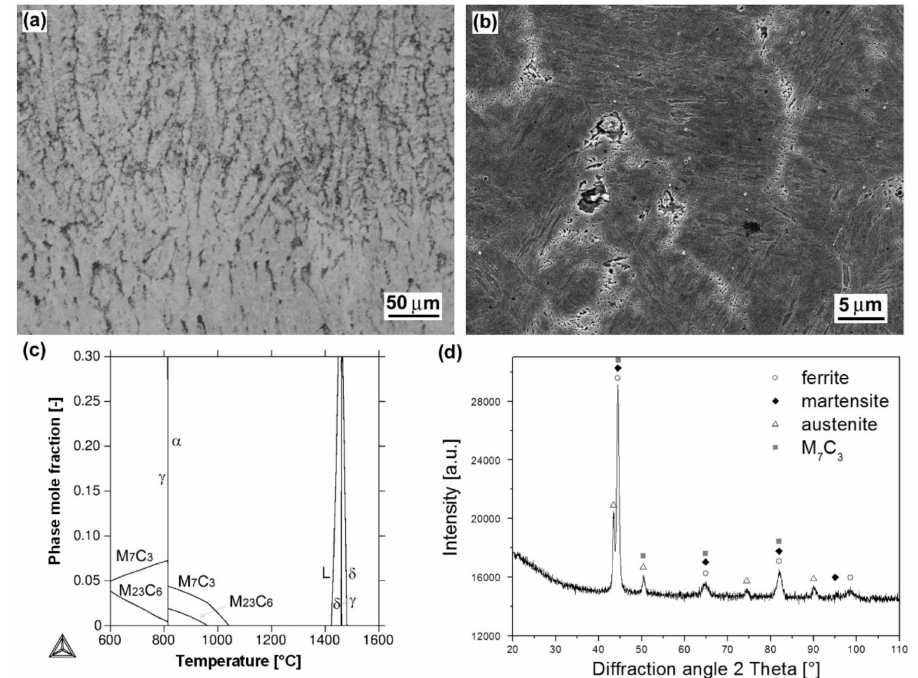
Figure 5. Characterization of “E DUR 600” hardfacing: overall microstructure visualized by LOM ( a ); detailed microstructure visualized by SEM ( b ); thermodynamic calculation of equilibrium phase composition depending on temperature ( c ); XRD-pattern representing experimentally determined phase composition ( d ).